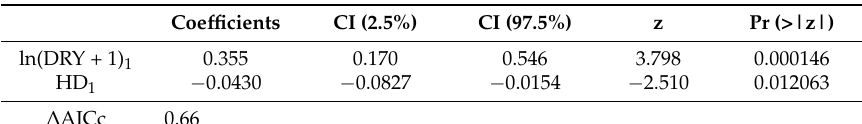
Table 4. Coefficients and confidence intervals (CI), Wald test score (z) and p ‐ values for the selected model.